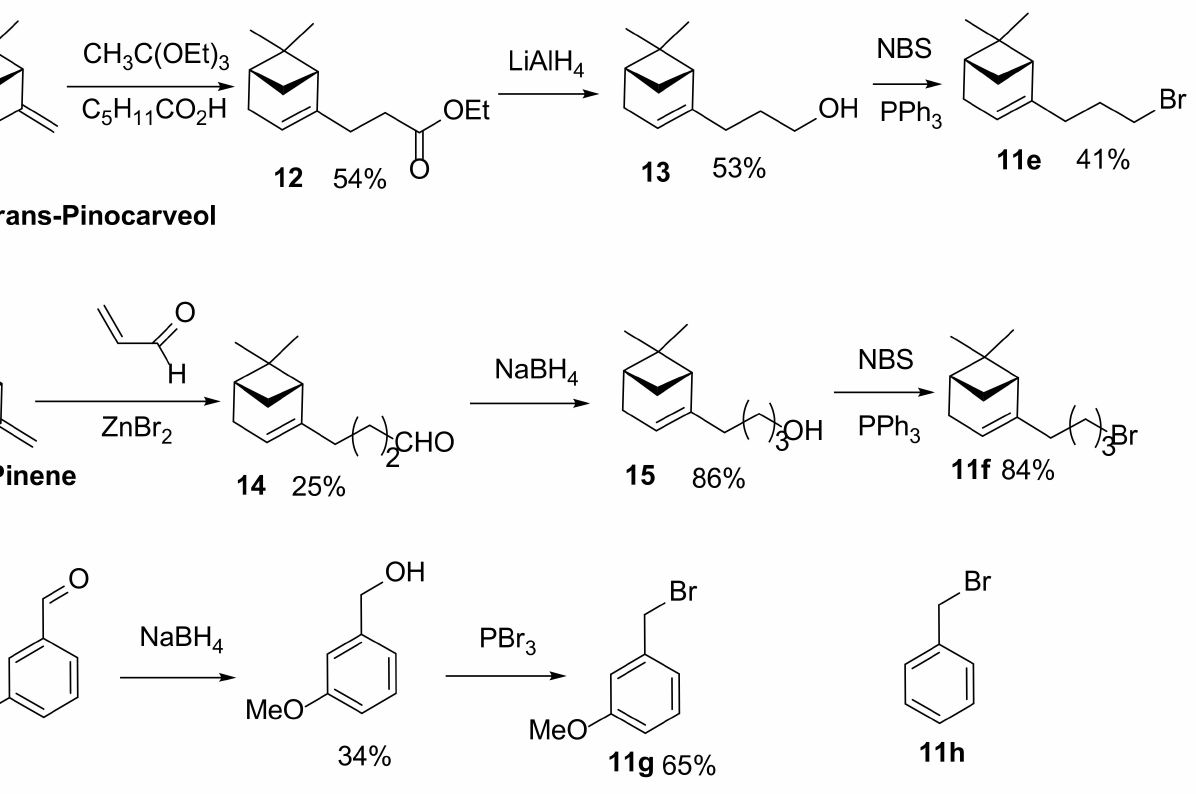
Scheme 3. Synthesis of bromides 11e – h